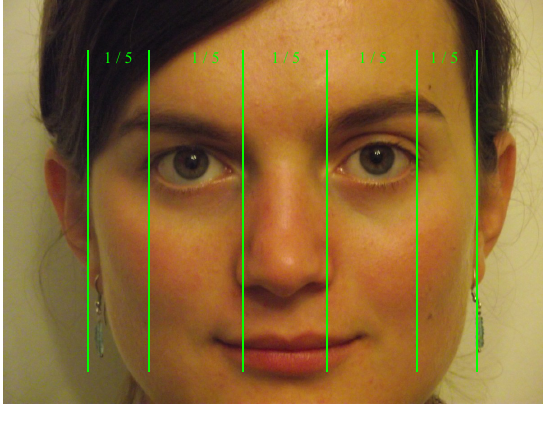
Figure 5. Neoclassical cannon (inspired by [21]). Vertical fifths of the human face; the eye usually measures one fifth of the human